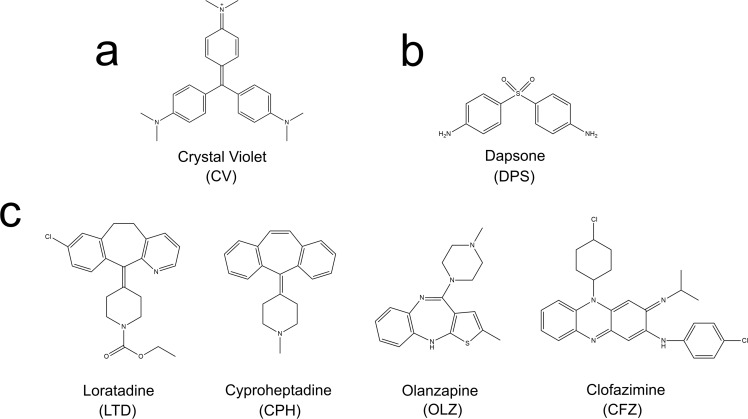
Chemical structures of crystal violet, its analogues and negative control.The figure shows the chemical structure of crystal violet (a), the structure of the negative control, dapsone, (b) and the structures of the four crystal violet structural analogues loratadine, cyproheptadine, olanzapine and clofazimine (c).